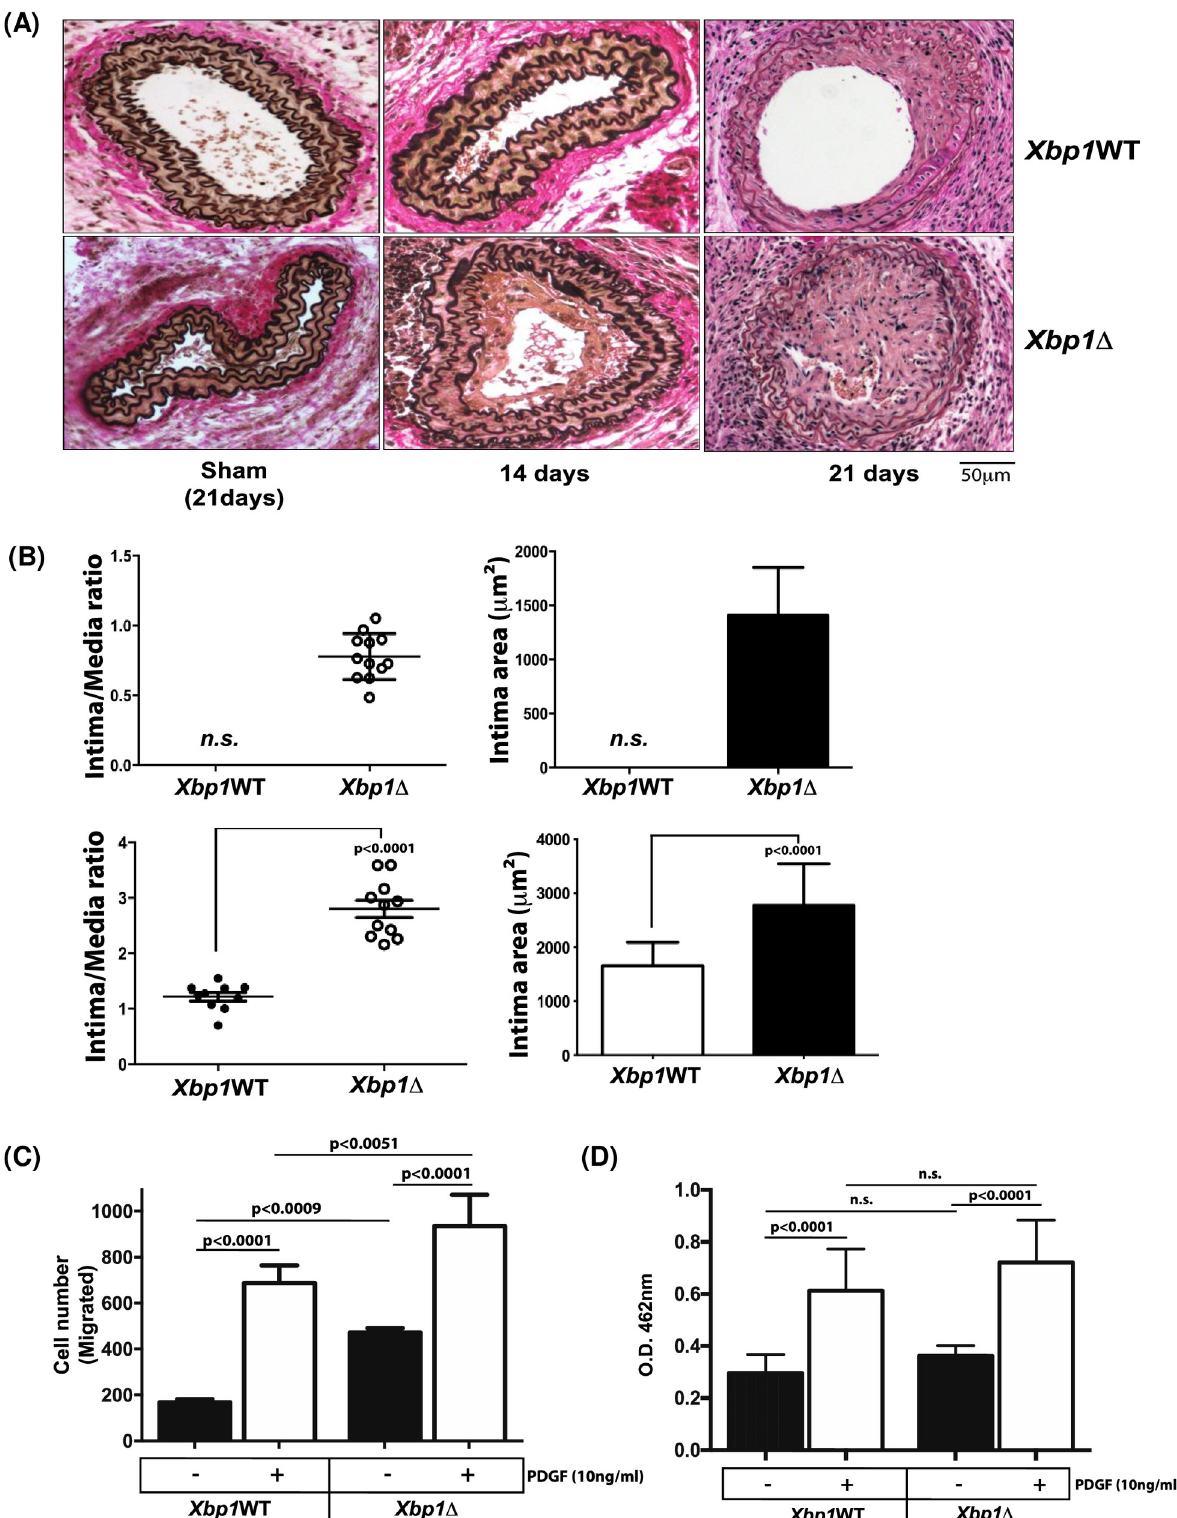
Fig 1. Increased neointimal hyperplasia after carotid artery ligation in Xbp1 VSMC-specific knockout mice. (A) Mice were studied 14 to 21 days after carotid artery ligation. Verhoff-van Gieson elastin staining of representative sections of Xbp1 fl/fl ( Xbp1 WT) and Xbp1l f/fl ;SM22 α -Cre ( Xbp1 Δ )